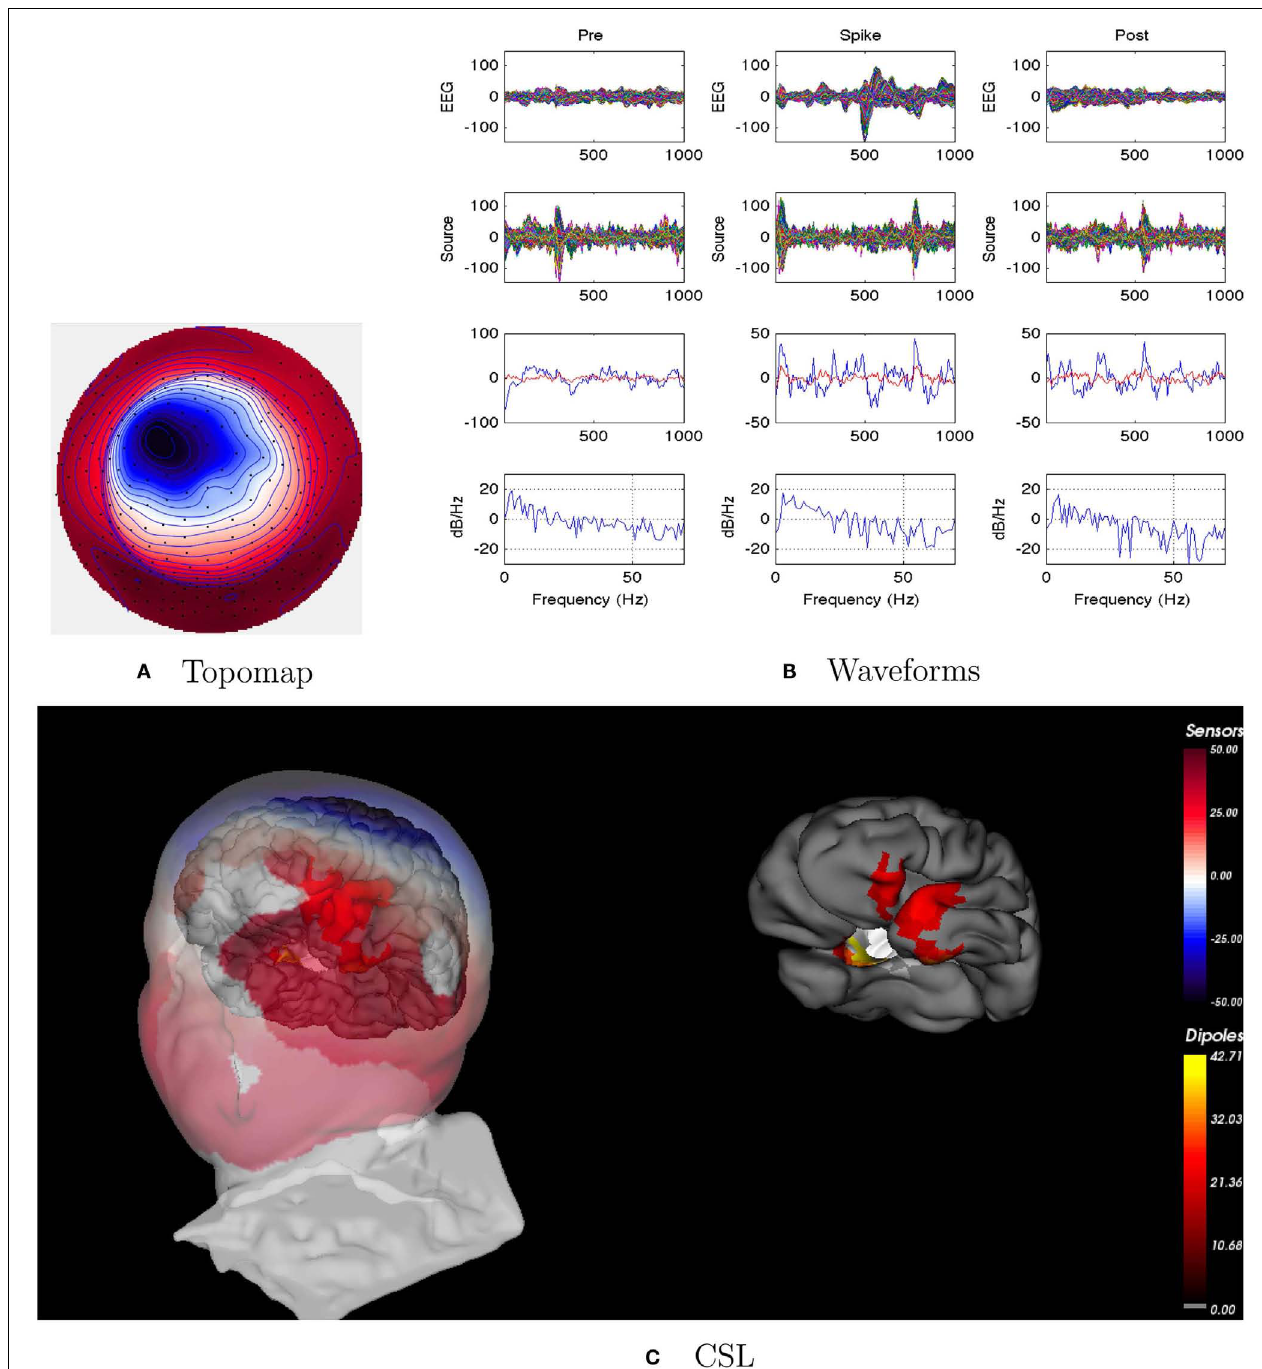
source waveforms (third row) shown in forth row. Note that the dipole location of the blue trace is in the left-frontal lobe. In (B) , each column represents 1s of data from a 3-s segment. Middle column represent data centered on the spike peak. (C) Electrical source localization with the patient’s individual electrical head model. Left: scalp potential reconstructed from the source estimate (at 50% of spike peak). Right: partially inflated brain illustrating the dominant source associated with the data illustrated in left figure (location of dipole described by blue trace in (B) , third row). Data was thresholded to only show top 5%